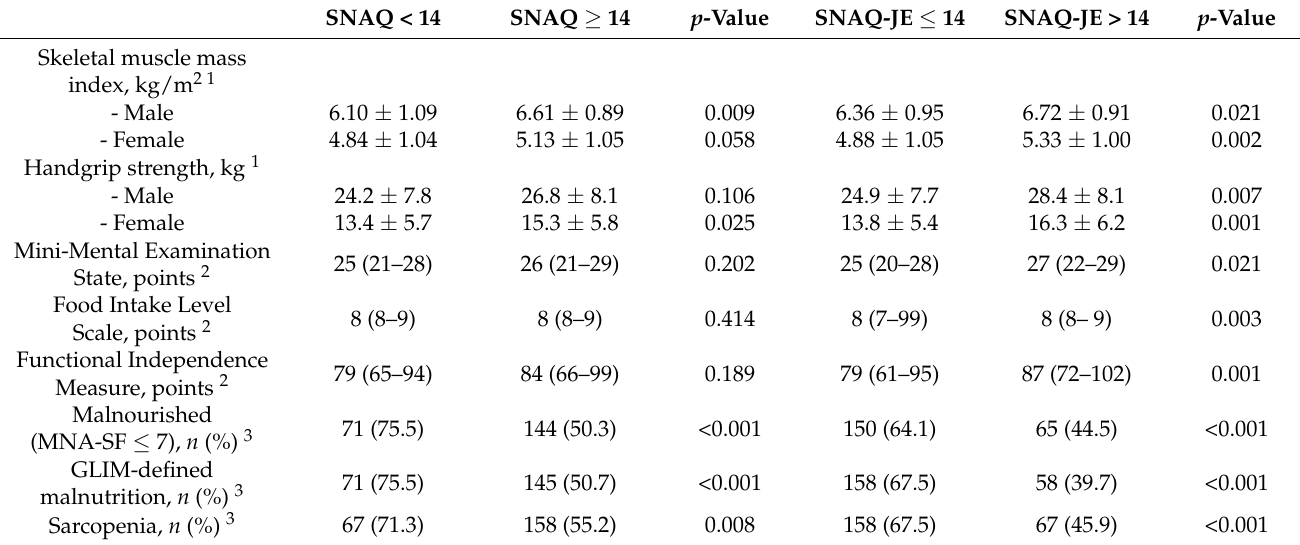
Table 2. Patients’ physical characteristics according to appetite